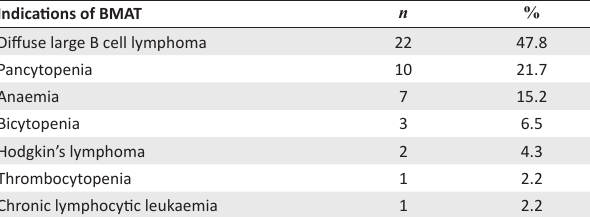
TABLE 2: Indications for bone marrow examination of 46 † cases reported to be HIV-positive at a hospital in KwaZulu-Natal, South Africa, January 2016 to